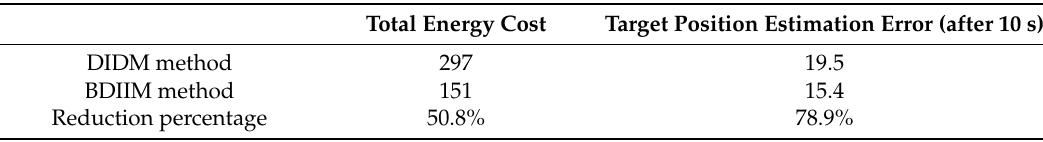
Figure 14. Energy cost and target position estimation in WC performance: ( a ) Total energy cost. ( b ) Target position estimation error. ( — : BDIIM; -- : DIDM). Table 8. Energy cost and position estimation error of the nodes in WC.